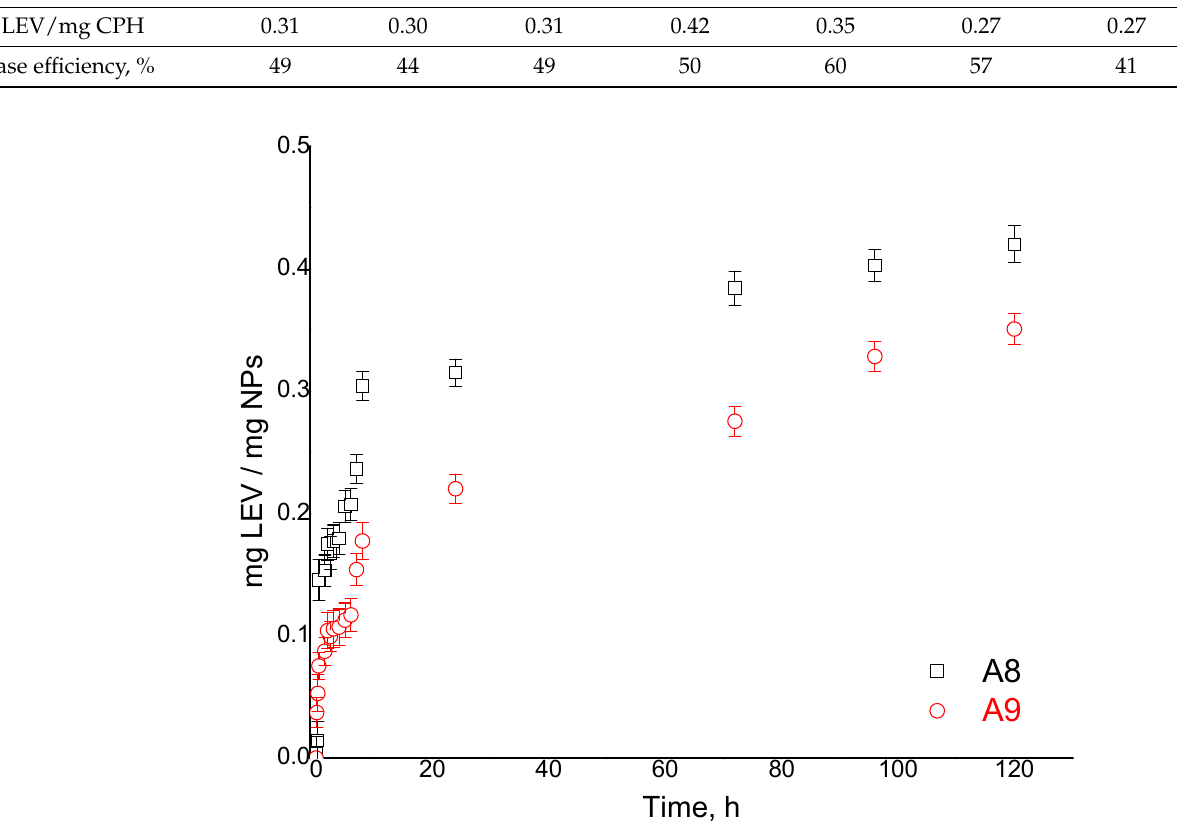
Figure 10. Chitosan particulate hydrogel in vitro LEV release.